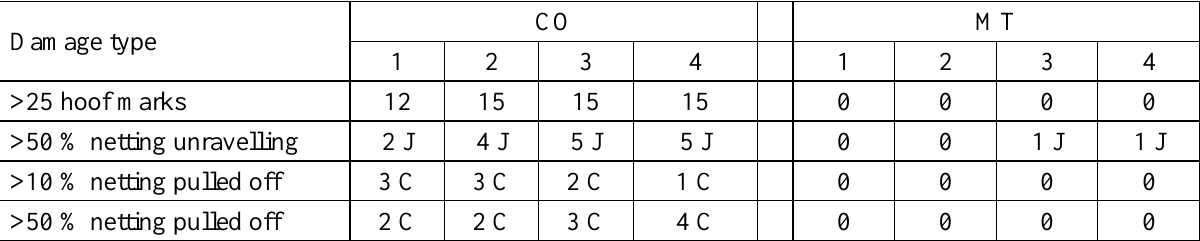
Table 4. Observations of hoof impact and netting damage across the 15 plots at each restoration site, Coire Odhar (CO) and Meall nan Tarmachan (MT), in the four years following treatment with heather brash and geotextiles. C = Coir netting; J = GeoJute